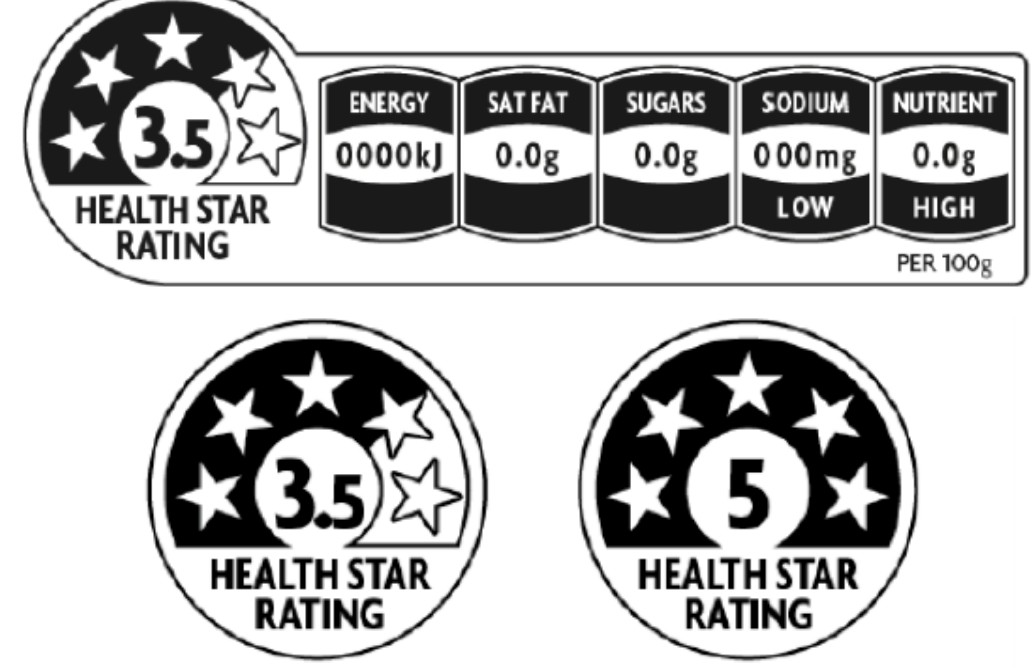
Figure 1. Example of Health Star Rating label (HSR) label formats